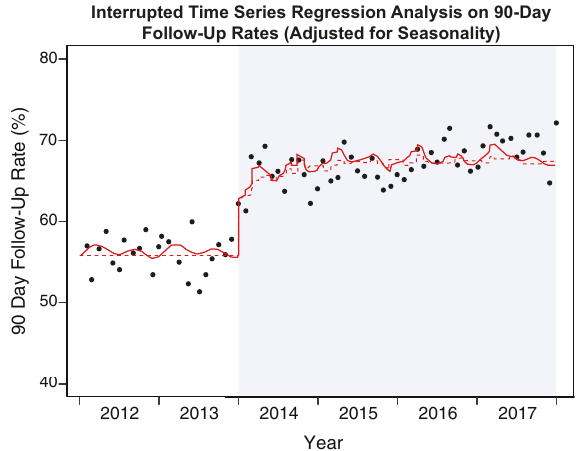
Fig. 3 Interrupted time series regression analysis on 90-day follow-up rates (adjusted for seasonality). Interrupted time series of pre-order era and EMR-order era using monthly data based on the Poisson regression model adjusted for seasonality. Solid line: predicted trend based on seasonally adjusted model. Dashed line: de-seasonalized trend.